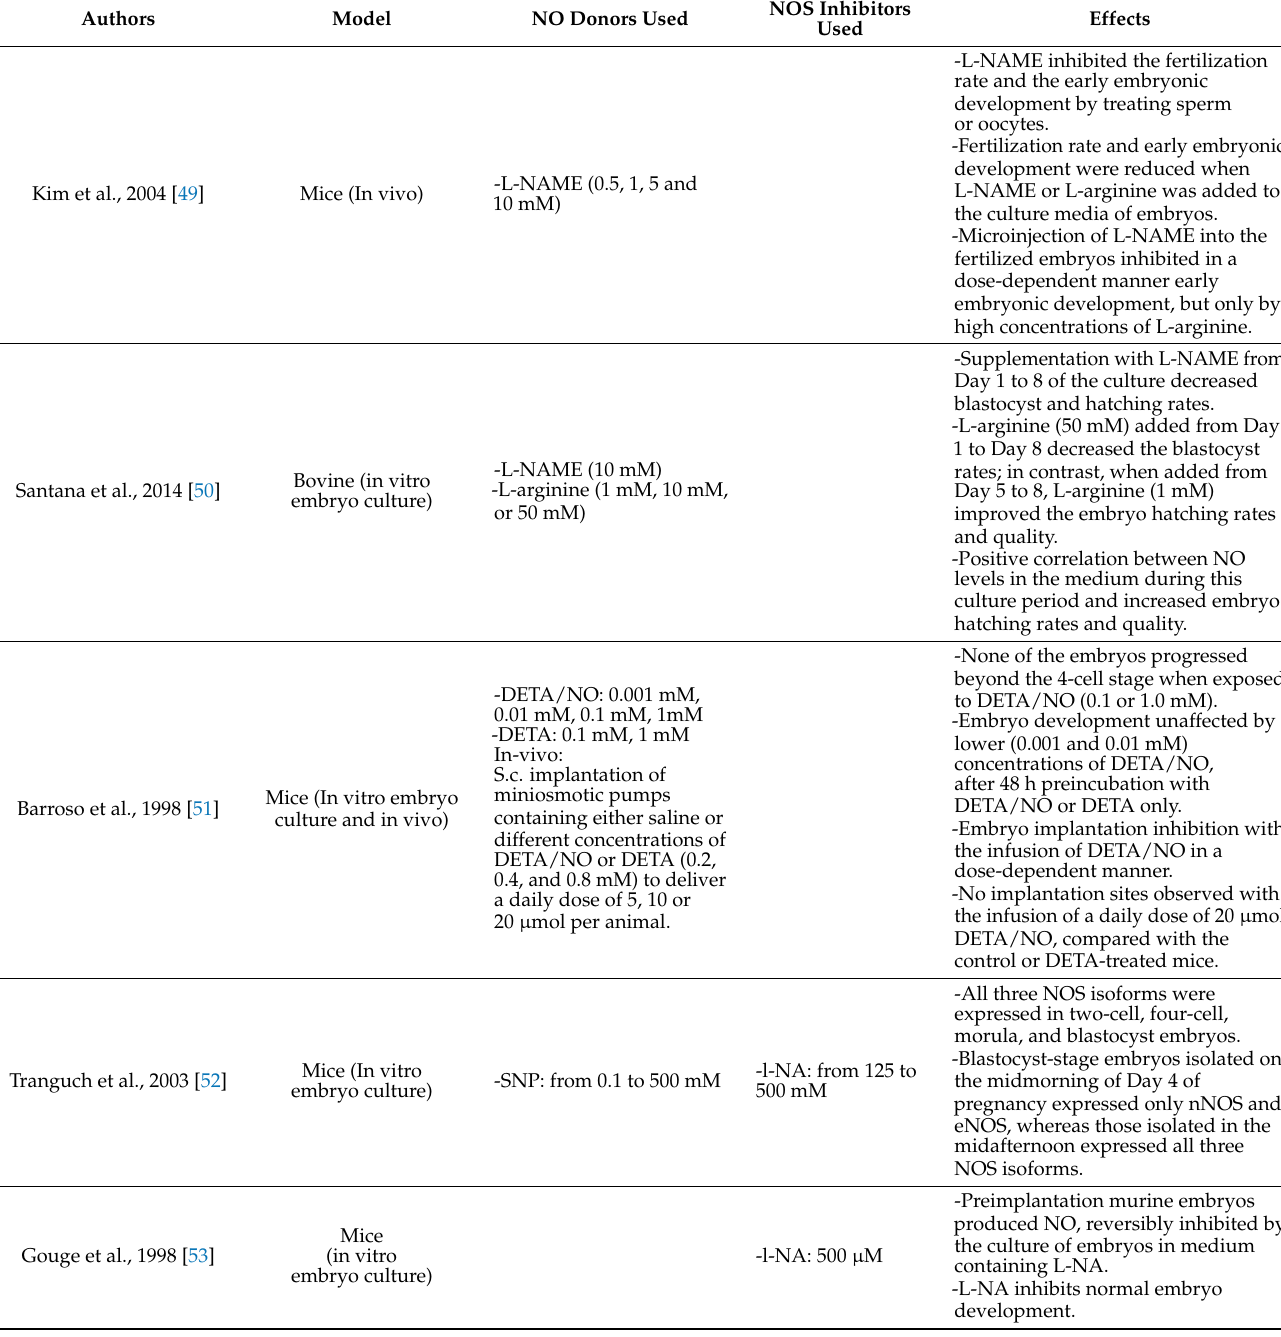
Table 4. Experimental studies investigating the role of NO in